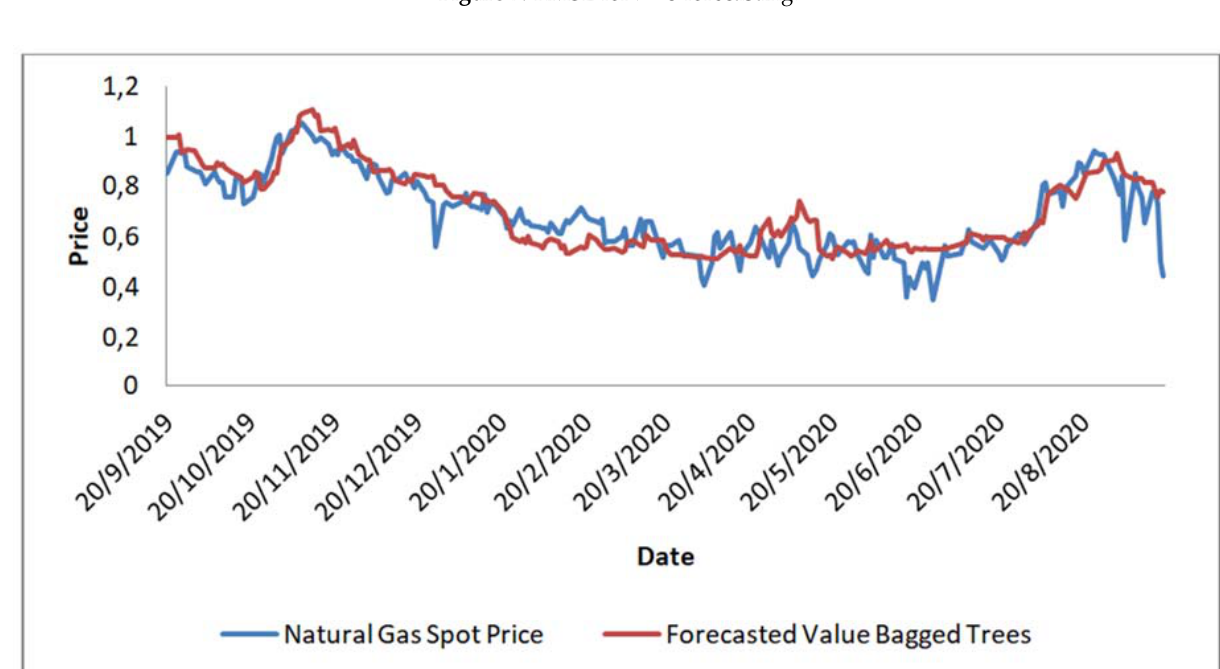
Figure 8. Comparison of the actual natural gas spot prices and the predicted prices with the bagged trees model for t + 3 in the out-of-sample part of the